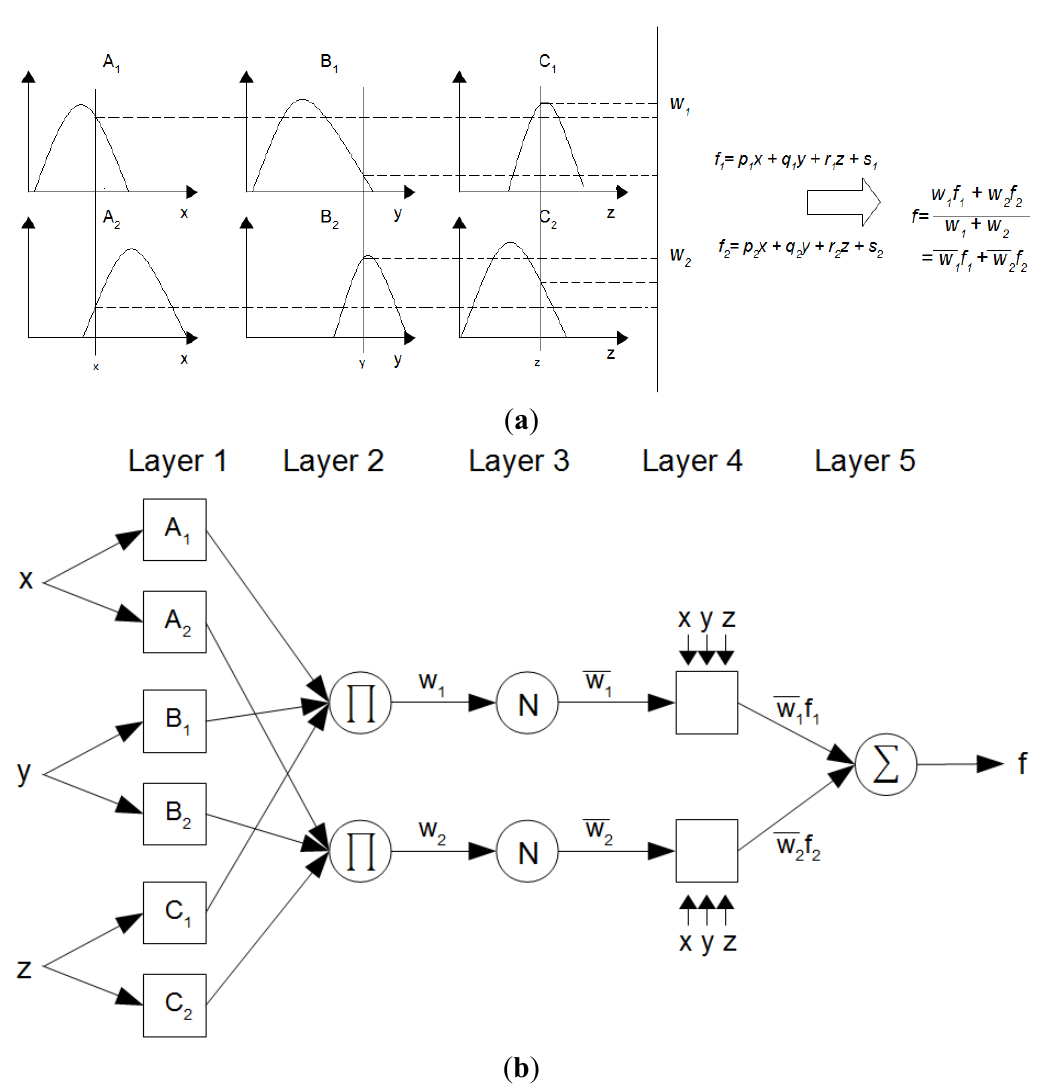
Figure 2. ( a ) Example of a Sugeno Inference Model: three inputs and two rules and ( b ) The equivalent ANFIS